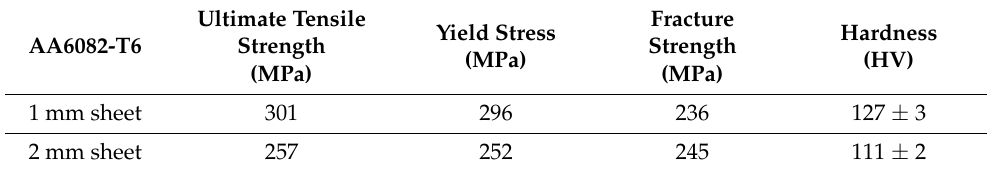
Table 2. The mechanical properties of the two base material sheets of AA6082-T6.